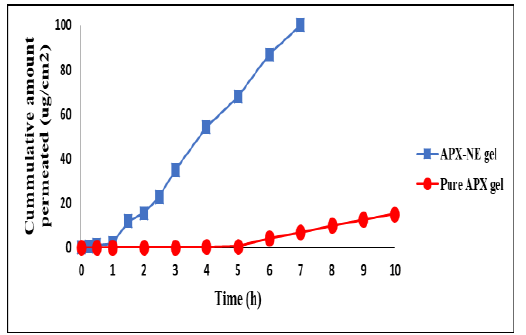
Figure 5. Comparative ex vivo permeability through human stratum corneum of pure APX gel (red) and APX-NE gel (blue)